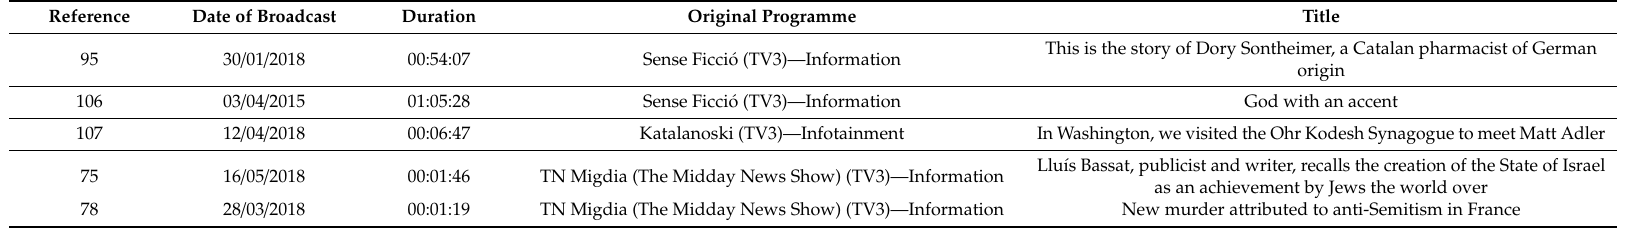
Table 3. Audio-visual material analysed where the perspective of Judaism